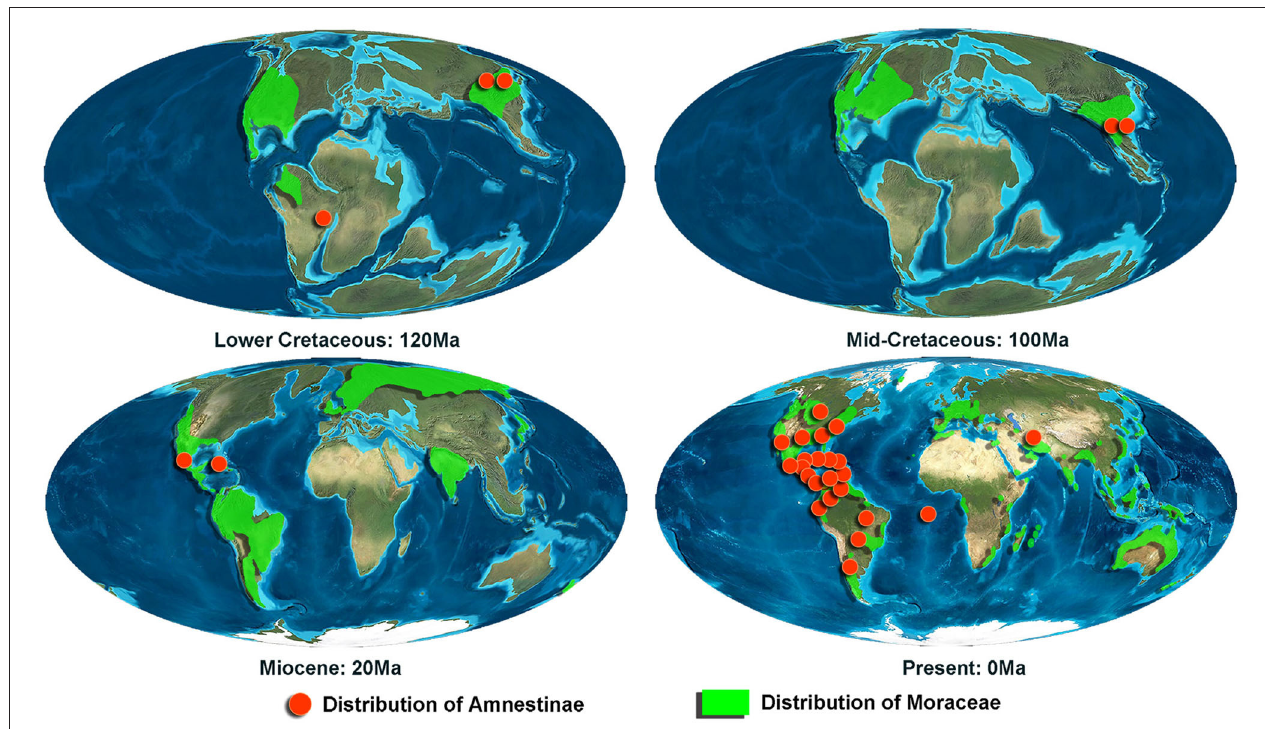
FIGURE 12 | Distribution of Amnestinae and Moraceae in different geological ages. Red dots represent the distribution of Amnestinae; green outlines represent the distribution of